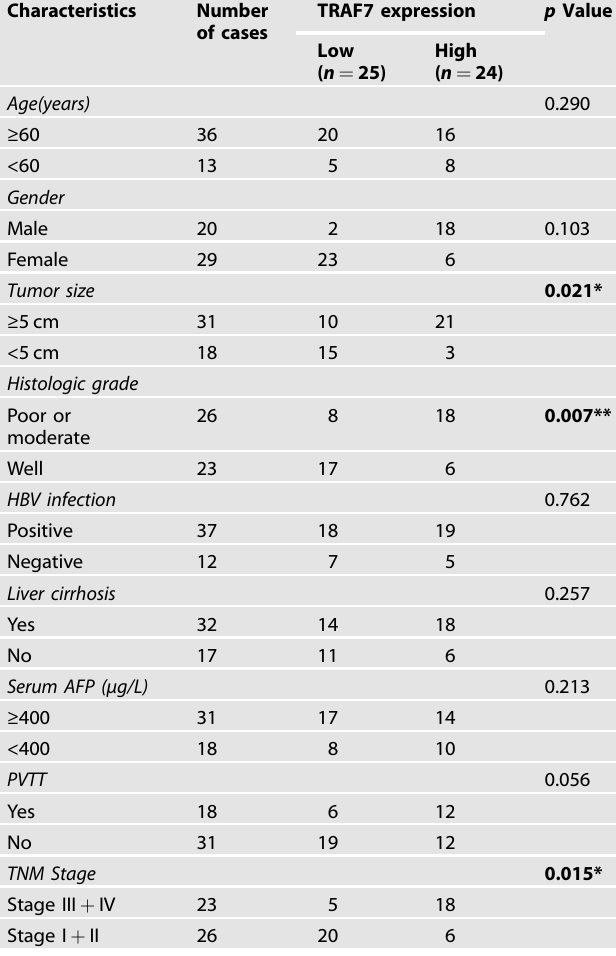
Bold values indicates statistically signi fi cant * p < 0.05, ** p <